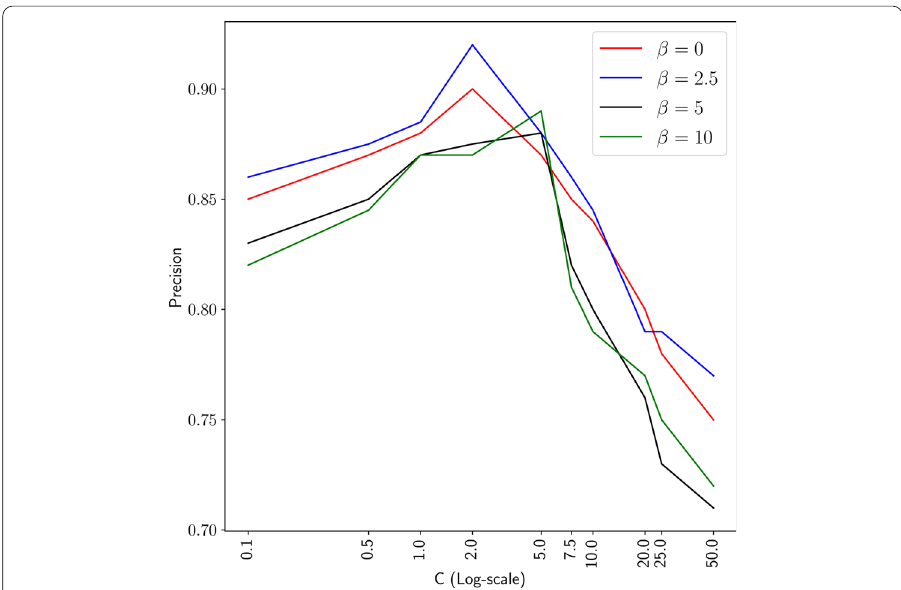
Fig. 4 The impact of weighting heuristic (Eq. 6) in precision on human ES cells across chromosomes